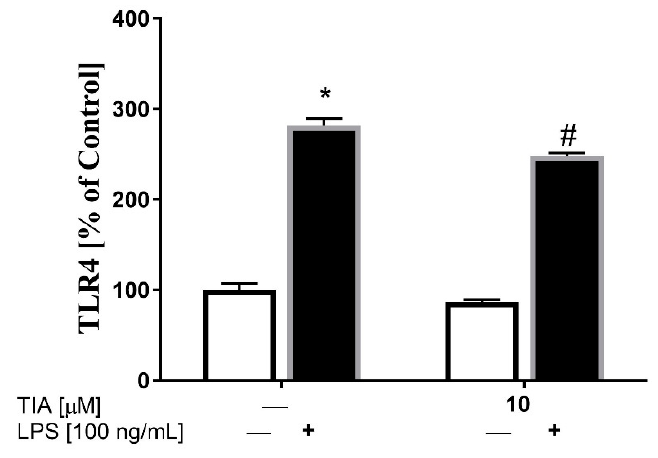
Figure 5. The effect of tianeptine (TIA) on Toll-like receptor 4 (TLR4) levels measured using an ELISA kit in vehicle- and LPS-treated primary microglial cells. Microglial cells were pretreated with tianeptine (TIA; 10 µ M) for 30 min, and then with lipopolysaccharide (LPS; 100 ng/mL) for 24 h. The data are presented as the mean ± SEM percentage of control (vehicle-treated cells) from independent experiments ( n = 6 in each group). The results were statistically evaluated using two-way analysis of variance (ANOVA) with a Duncan post-hoc test to assess the differences between the treatment groups. Significant differences from the control group (vehicle-treated cells) are indicated by * p < 0.05; differences between LPS-treated groups and pre-treated with tianeptine and then stimulated with LPS groups are indicated by # p < 0.05.